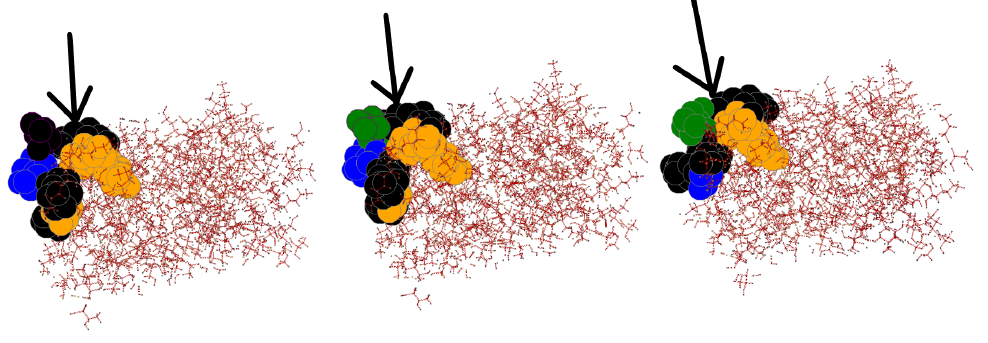
Figure 5. The 3D visualization of the rigid clusters of the Enhanced Green Fluorescent Protein ( left to right ): wildtype 2Y0G, PDB mutant 4KAG, and the computer-generated mutant. A deletion of aspartic acid at residue index 190 is modeled. The arrow points to the precise location of the InDel. The 5 largest clusters are colored, while all other clusters are